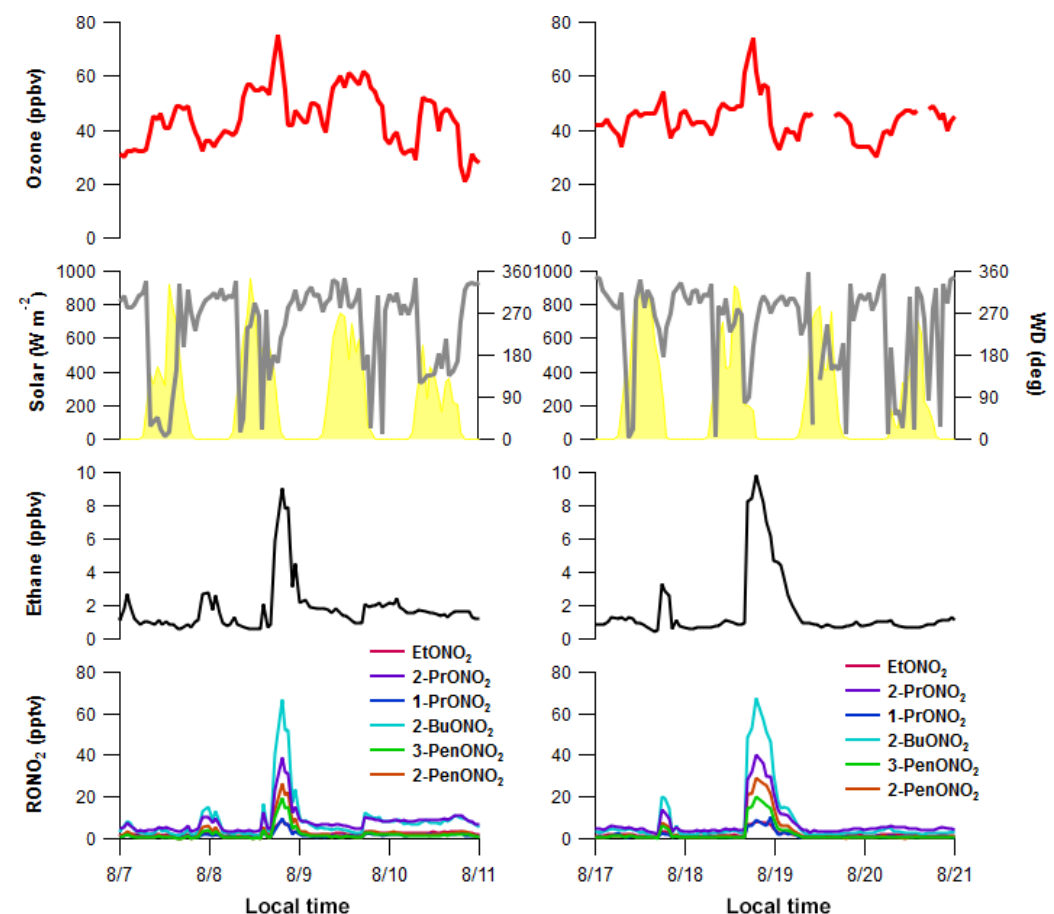
Figure 12. Time series plots of O 3 , solar radiation, wind direction, ethane, and the C 2 –C 5 alkyl nitrates during the (a) 8 August and (b) 18 August upslope